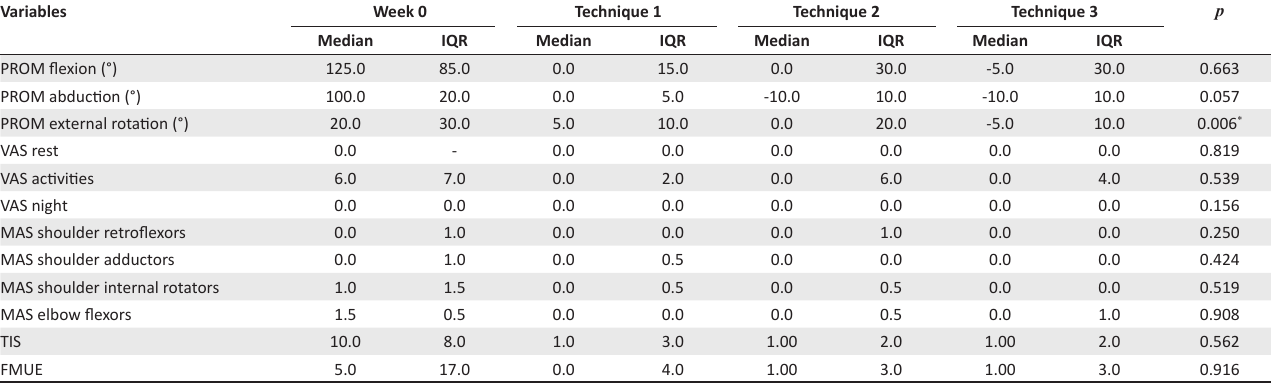
TABLE 2: Medians and interquartile ranges at baseline and changes in primary and secondary outcome parameters (medians and interquartile ranges [IQR]) for each intervention period ( n = 11).